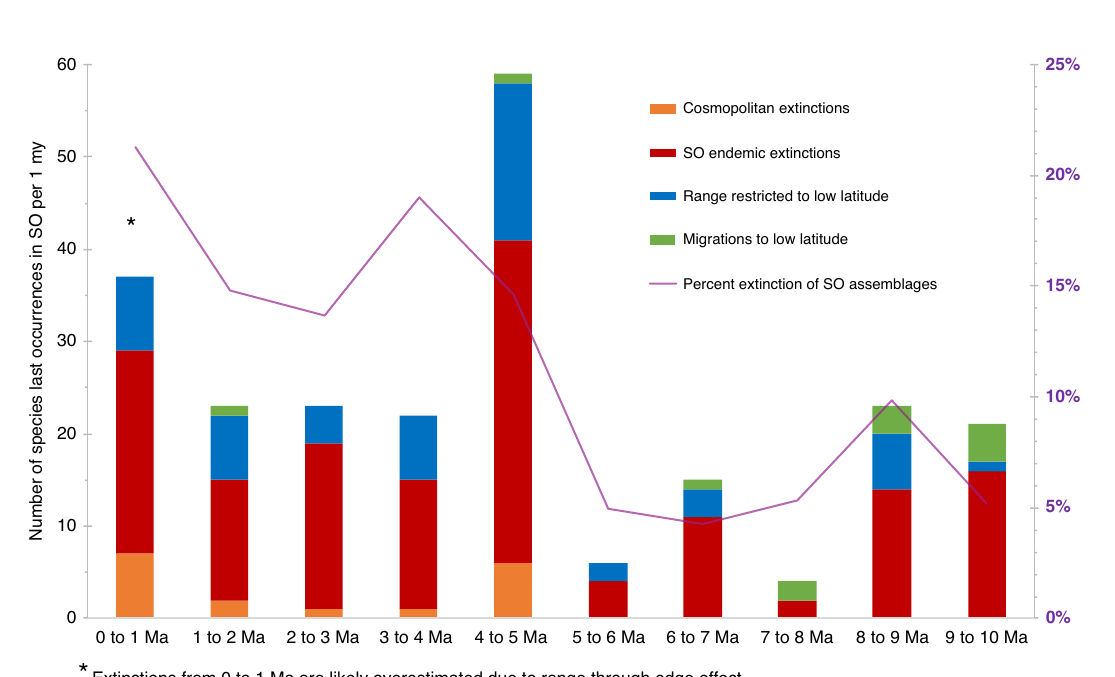
Fig. 2 Radiolarian evolution and sea surface temperature (SST) over the last 10 million years. In both panels, black points indicate raw species richness observed in each sample. Extrapolated species richness (asymptotic diversity estimates) are shown in gray. Error bars indicate the mean (center) ± standard error, based on 500 bootstrap replicates. Extrapolation was performed using the R package iNext 66 (Hill numbers of order q = 0), and is based on sample completeness 34 . A lowess smoother (span = 0.33) is applied to the lower panel to aid with visualization; a dashed line is used across the data gap. Evenness (Pielou equitability index 38 ) is plotted in blue, and boundary-crosser extinction rate 70 is plotted in red (most recent time bin removed due to edge effect, see “ Methods ” ). The green line in ( a ) refers to tropical Paci fi c radiolarian diversity recorded in the Neptune Sandbox Berlin (NSB) database 37 , which includes data from previous deep-sea drilling research (note broken scale). Southern Ocean radiolarian data were obtained from 9 and re-analyzed for this study using updated age models in NSB. Temperature data are re-plotted from 8, 29 , and are based on alkenone biomarker proxy reconstructions. In ( a ) the SST anomaly curve indicates mean tropical SST over time and one standard deviation from the mean, as reported in 8 . The gray data points show SST data from Site U1337 only 29 . In ( b ), the black line indicates the mean SST for compiled northern hemisphere and southern hemisphere mid and high latitudes 8 . The dashed line indicates the median value among these datasets, and the envelope refers to the maximum and minimum average temperatures among these datasets. Due to some uncertainty in Southern Ocean age models, only broad patterns on the scale of ~1 million year (Ma) should be considered in ( b ), rather than precise temporal correlations between radiolarian evolution and temperature. The gap in sampling between ~5 and 6.5 Ma shown in ( b ) is due to a regional sedimentation hiatus and high age model uncertainty of this speci fi c time interval at the Southern Ocean sites. Different shades of blue background in ( b ) refer to phases of Southern Ocean radiolarian response (see text).